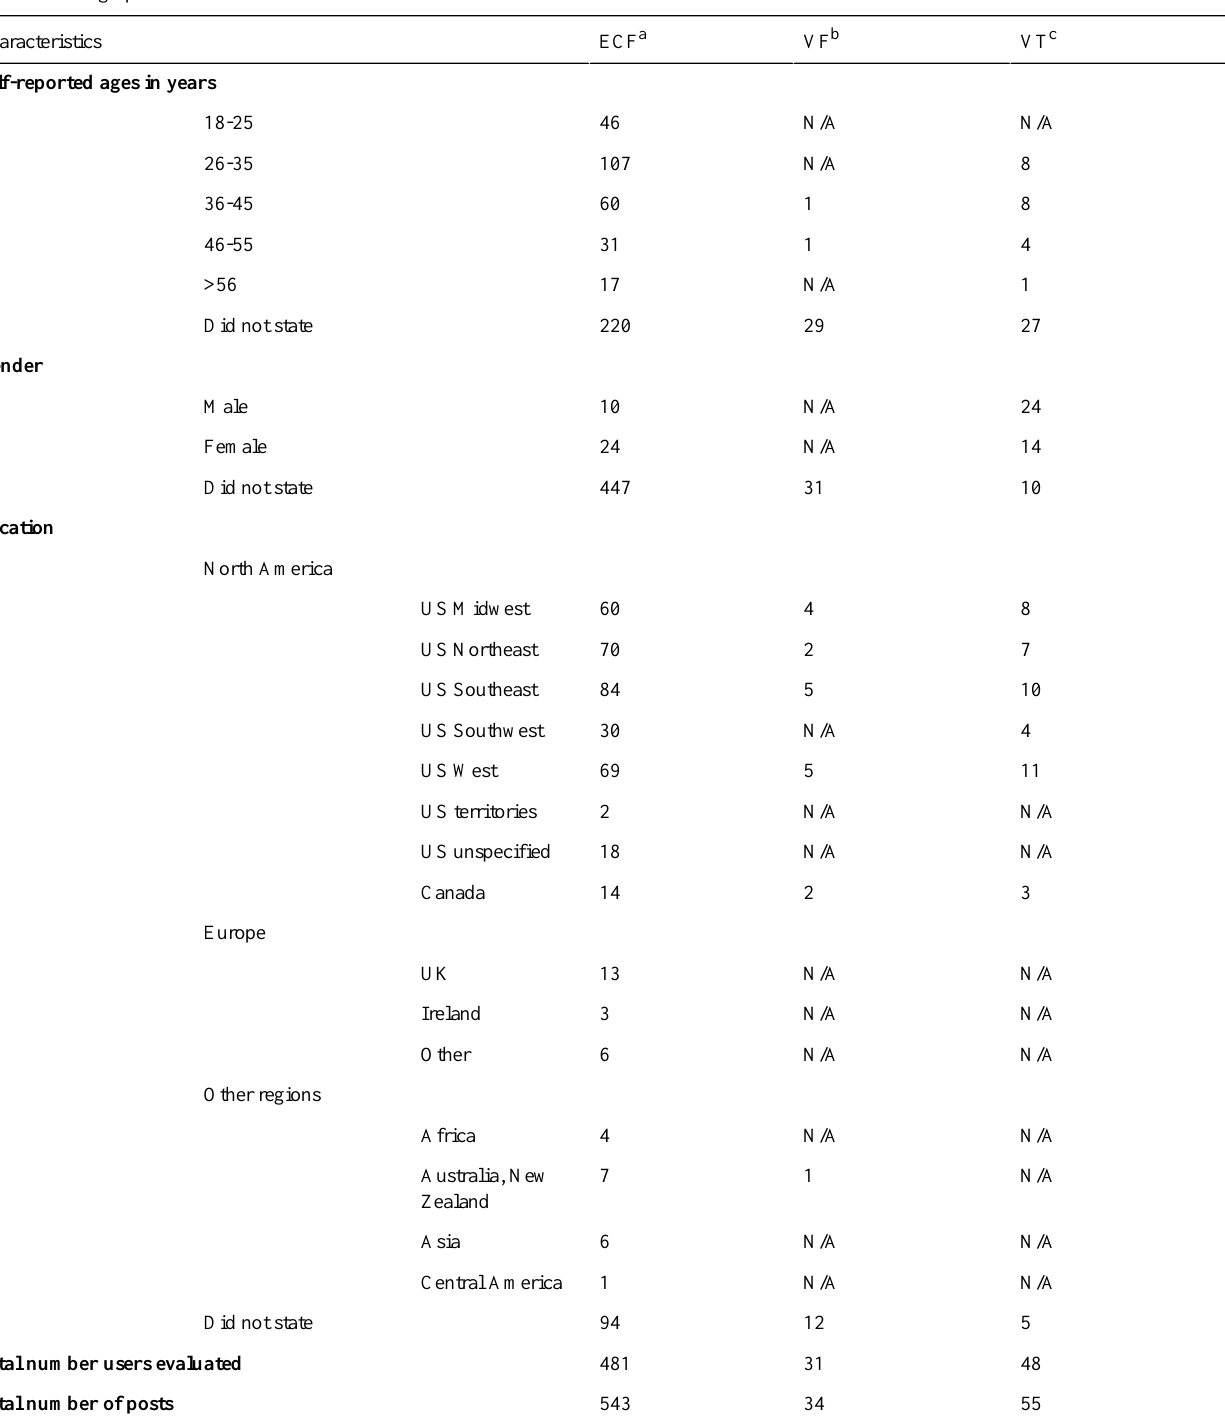
Table 1. Demographics of forum